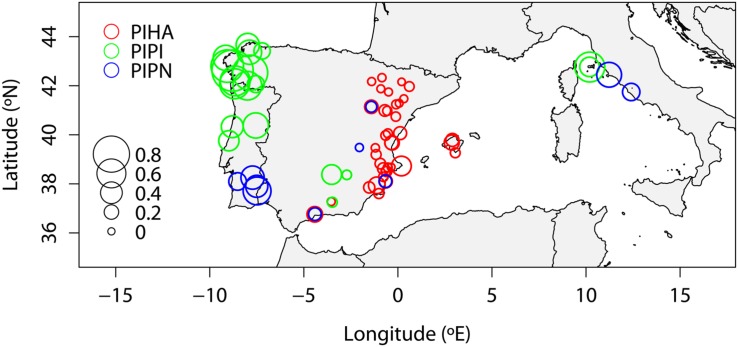
Map of the mean IADF frequencies (IADF_f) of the sites of the network detrended by age (x axis: longitude –W, +E). The amplitude of the circles is directly proportional to the frequency: wider circles are related to higher IADF frequency compared to smaller ones (PIHA, Pinus halepensis; PIPI, Pinus pinaster; PIPN, Pinus pinea).